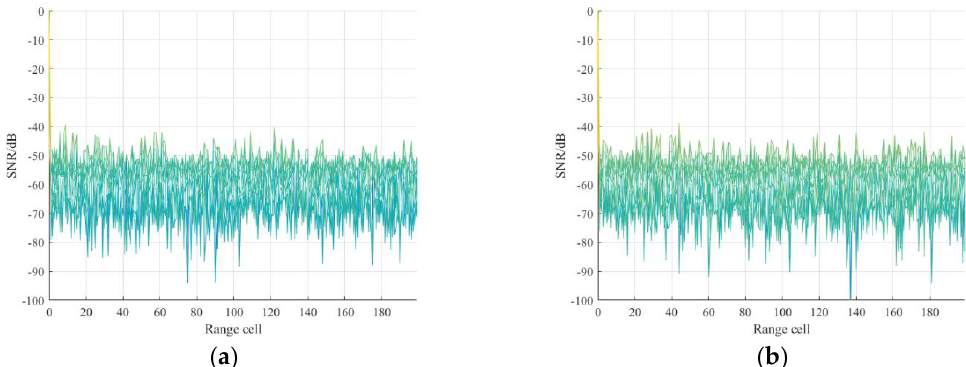
Figure 8. CIR estimation results in COST207 channel model of different method: ( a ) proposed method; ( b ) PN correlation method; ( c ) OMP method; ( d ) RLS method.